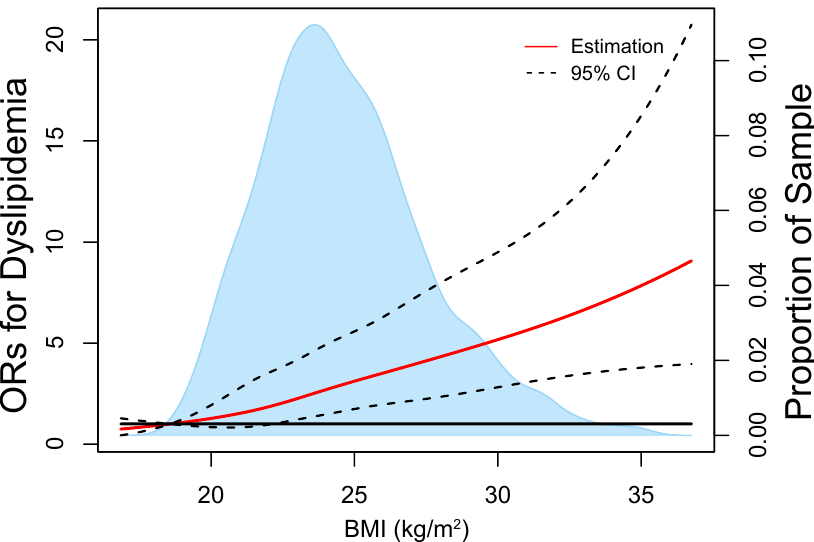
Figure 3. Representation of restricted cubic spline logistic regression models for BMI and risk of dyslipidemia. Red solid line shows OR as a function of BMI adjusted for age, age of children, numbers of birth, current smoking status, and current alcohol